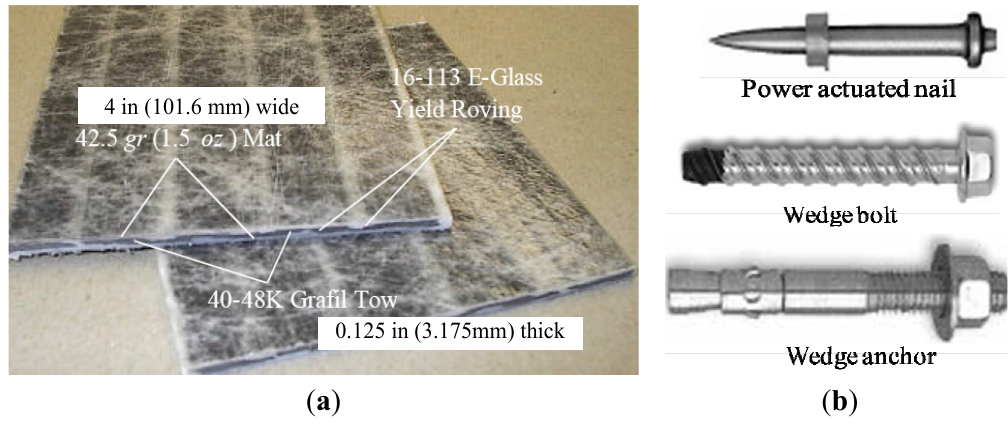
Figure 1. Components of the mechanically-fastened fiber-reinforced polymer (MF-FRP) system: ( a ) FRP strip; ( b )